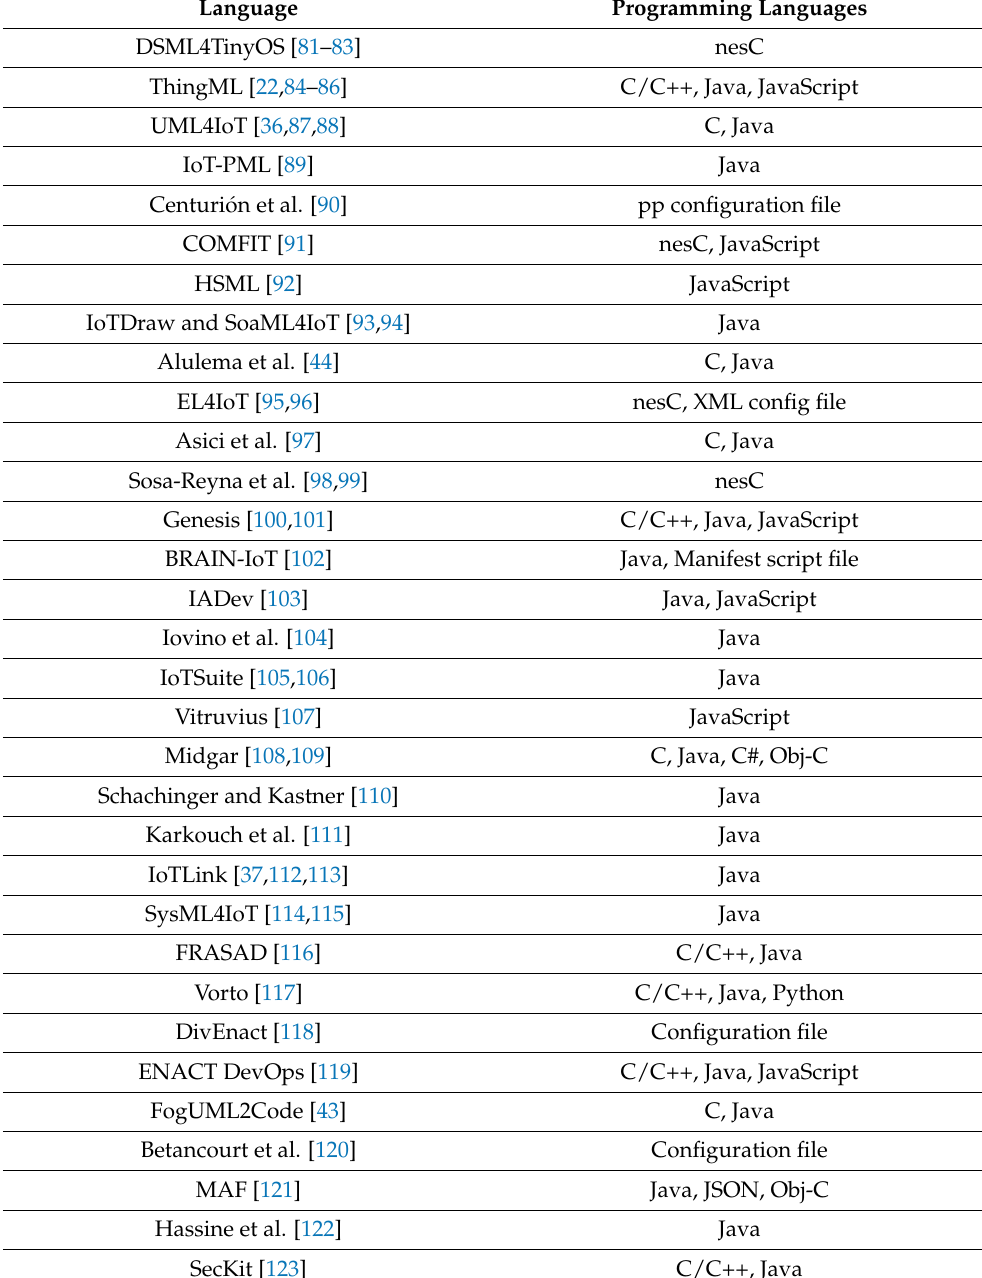
Table 5. The modeling languages for IoT that support automated code generation via their